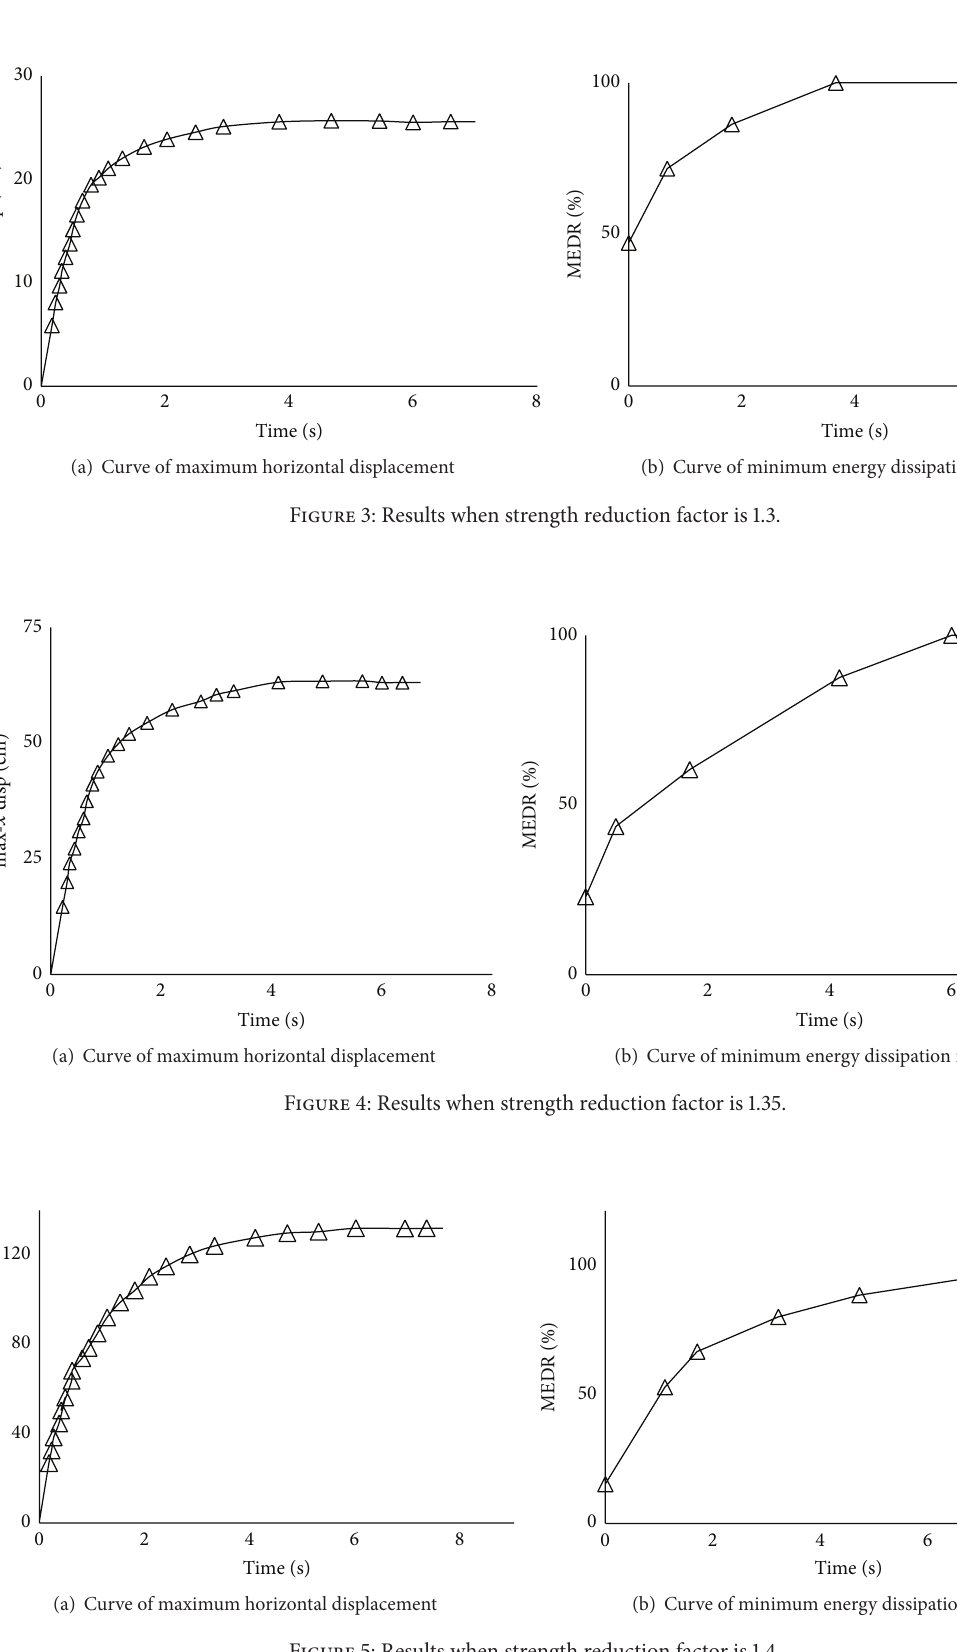
Figure 5: Results when strength reduction factor is